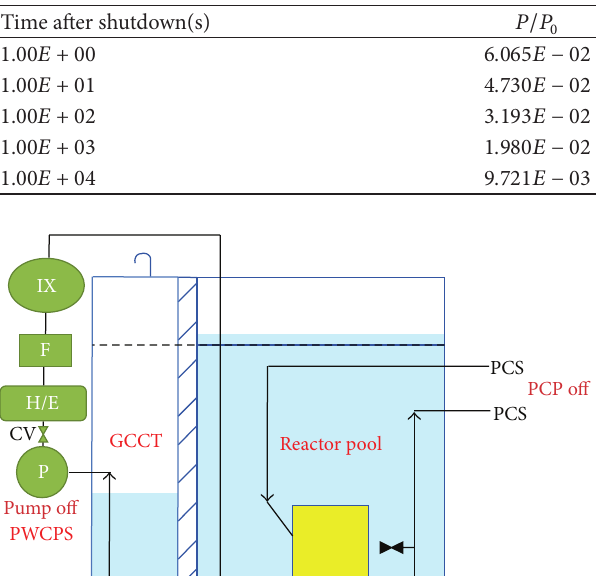
Table 1: ANSI/ANS-5.1-2005, Decay Heat Power in Light Water Reactors.